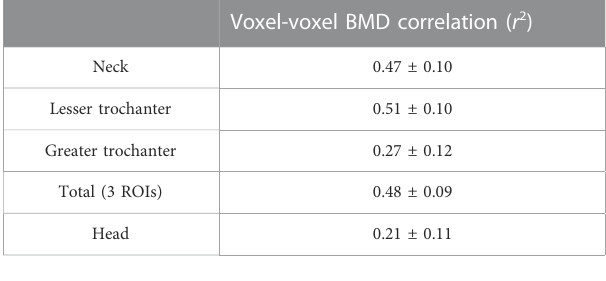
TABLE5MeanandstandarddeviationofthevoxelBMDcorrelationcoef fi